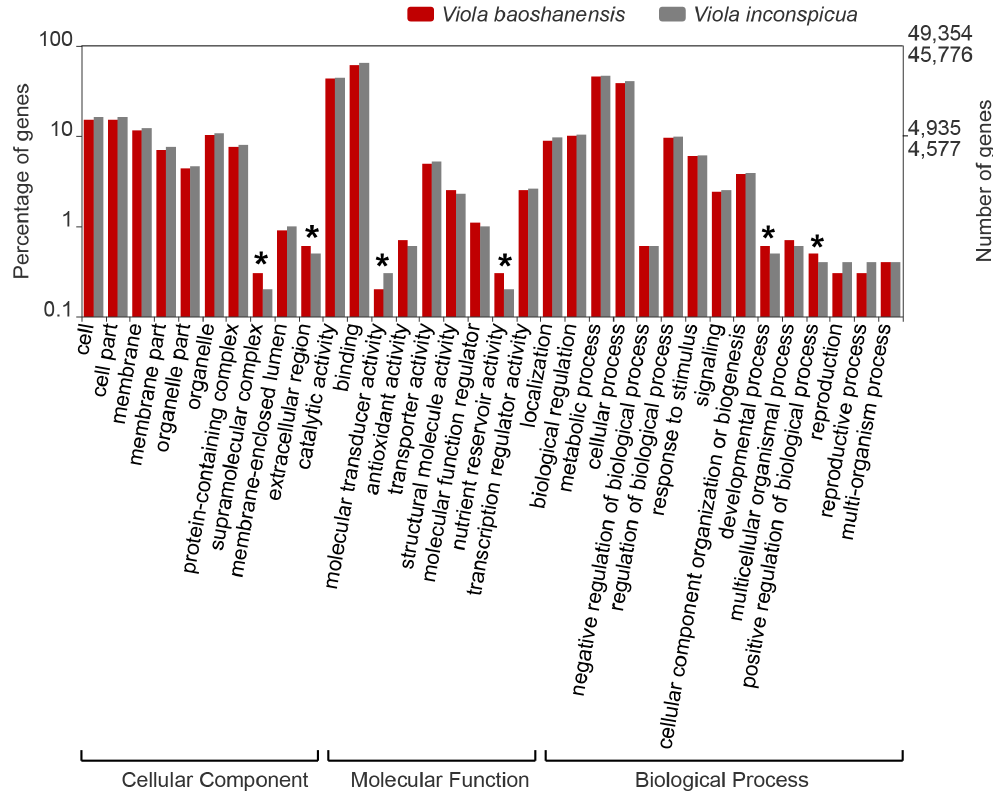
Figure 2. Gene Ontology (GO) distributions for Viola baoshanensis (red) and V. inconspicua (grey). Annotation results were mapped to categories in the second level of GO terms, respectively. Those GO terms that contain less than 0.1 % of the total genes were excluded from this graph. The asterisks represent significant di ff erences ( p < 0.05) between the two Viola species. See more details in Table S14. In the cellular component category, cell part (15.2% versus 16.3%) and membrane-related